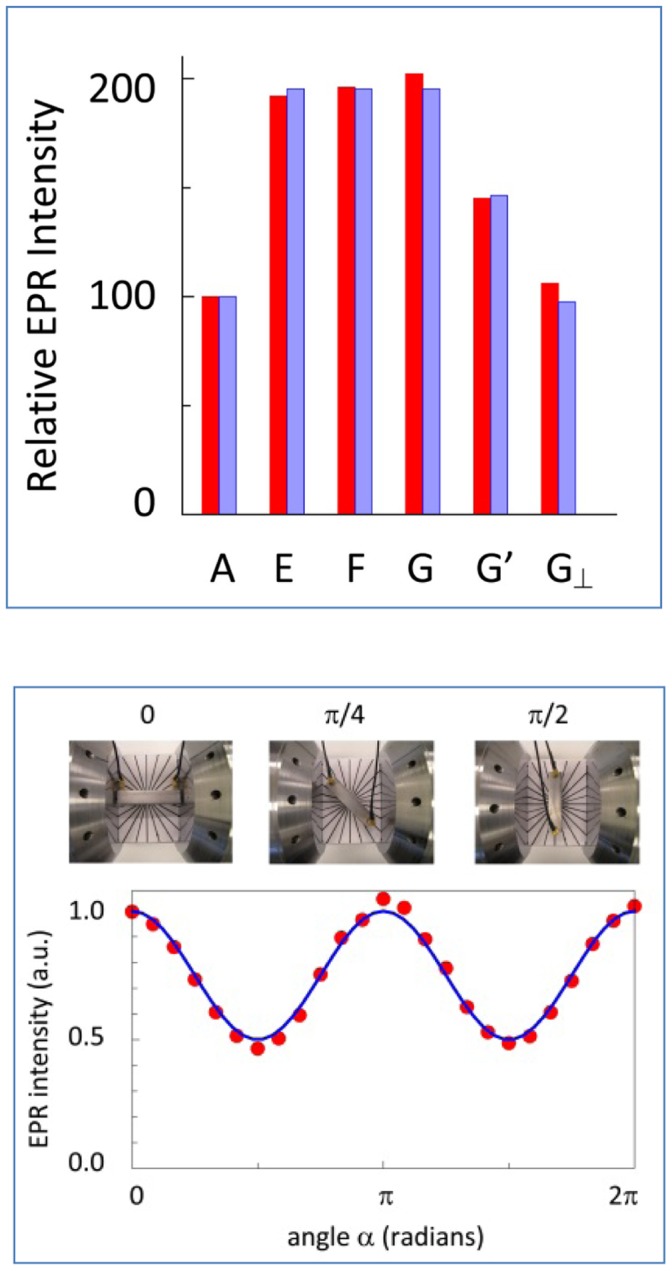
Signal intensity as a function of sample-compartment geometry.The 42 mm standard cell is partially filled with teflon spacers to displace paramagnetic sample. Bar A is the Mn(II) signal amplitude for a fully sample-filled cell in TEM || B orientation. Red bars are measured intensities and blue bars are theory-predicted. Subscript ⊥ indicates TEM ⊥ B orientation. In B a teflon spacer occupies half of the cell; in C the spacer is a cylinder around the inner conductor over the full cell length; in D two sector spacers occupy opposite positions in ‘butterfly’ orientation along the full length of the cell. The lower panel shows a full 360 degree rotation experiment for the ‘butterfly’ setup with intensity data fitted to eqn (30).